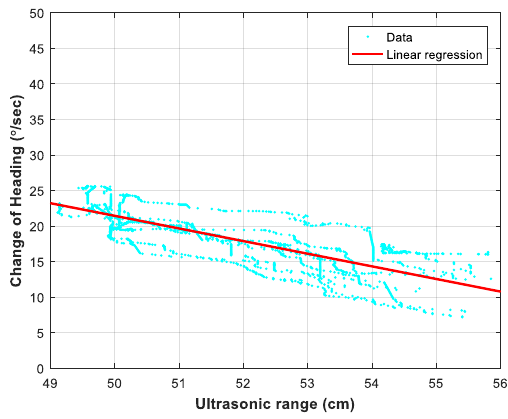
Figure 8. Ultrasonic sensor range versus the change of heading along with the linear regression model for the right turn category of the first data